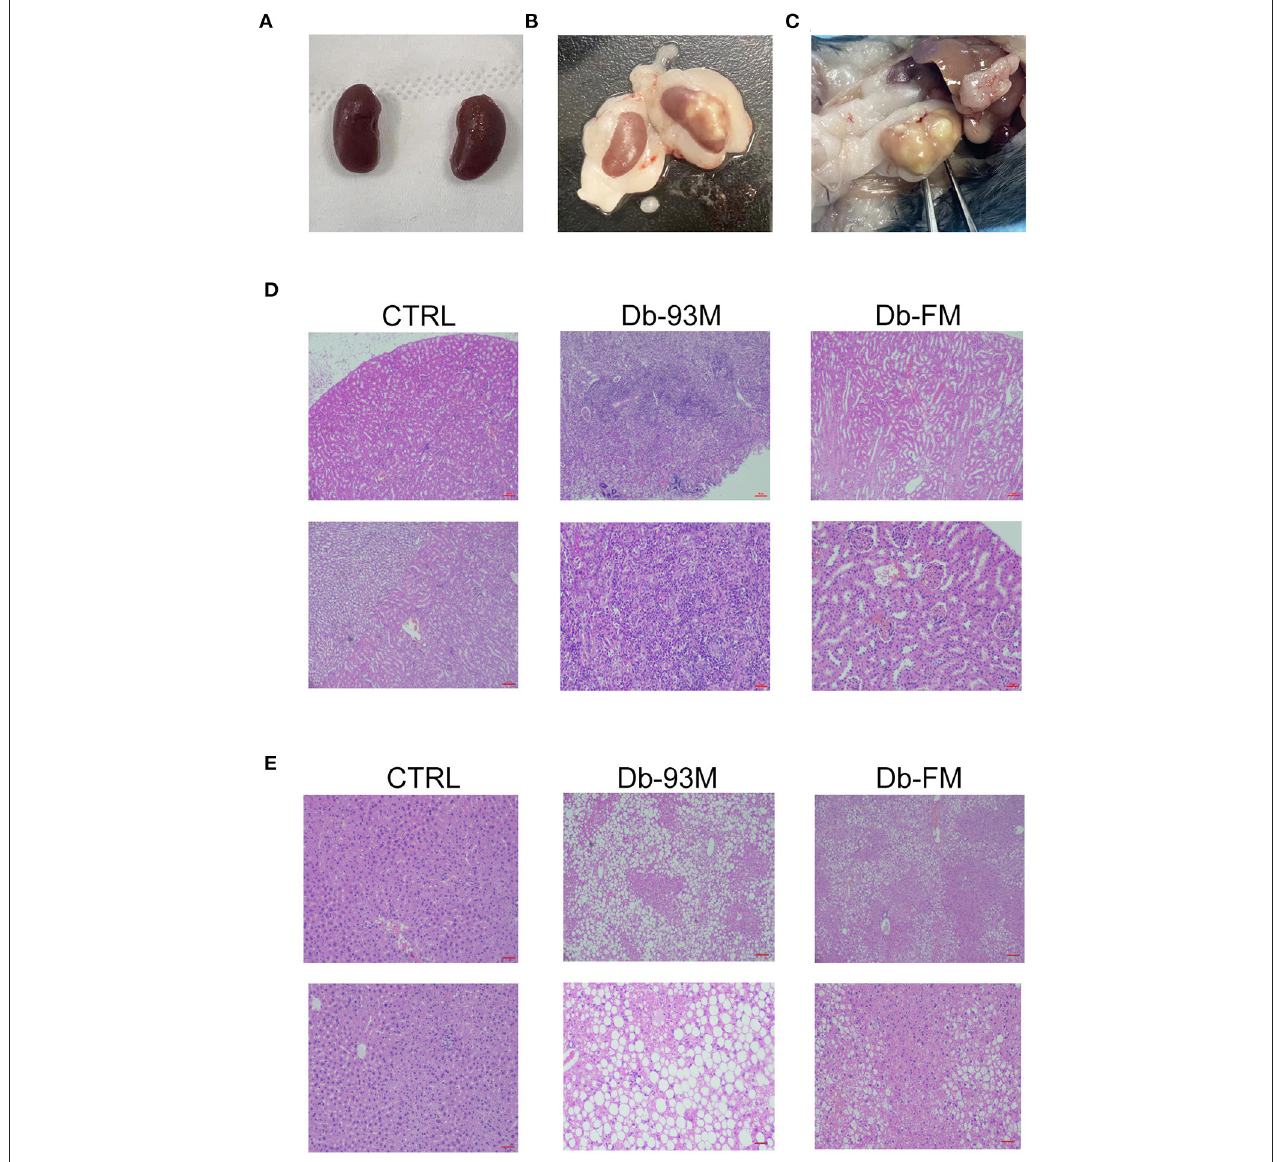
FIGURE 2 | Histopathological analysis. (A) The appearance and morphology of the kidneys from CTRL group; (B) the appearance and morphology of the kidneys, the left one is the kidney from the Db-FM group, the right one is the kidney from the Db-93M group; (C) the kidney of mice from the Db-93M group; (D) histopathological examination of kidney tissues (top: 40 × ; bottom: 200 × ); (E) histopathological examination of liver tissues (top: 40 × ; bottom: 200 ×